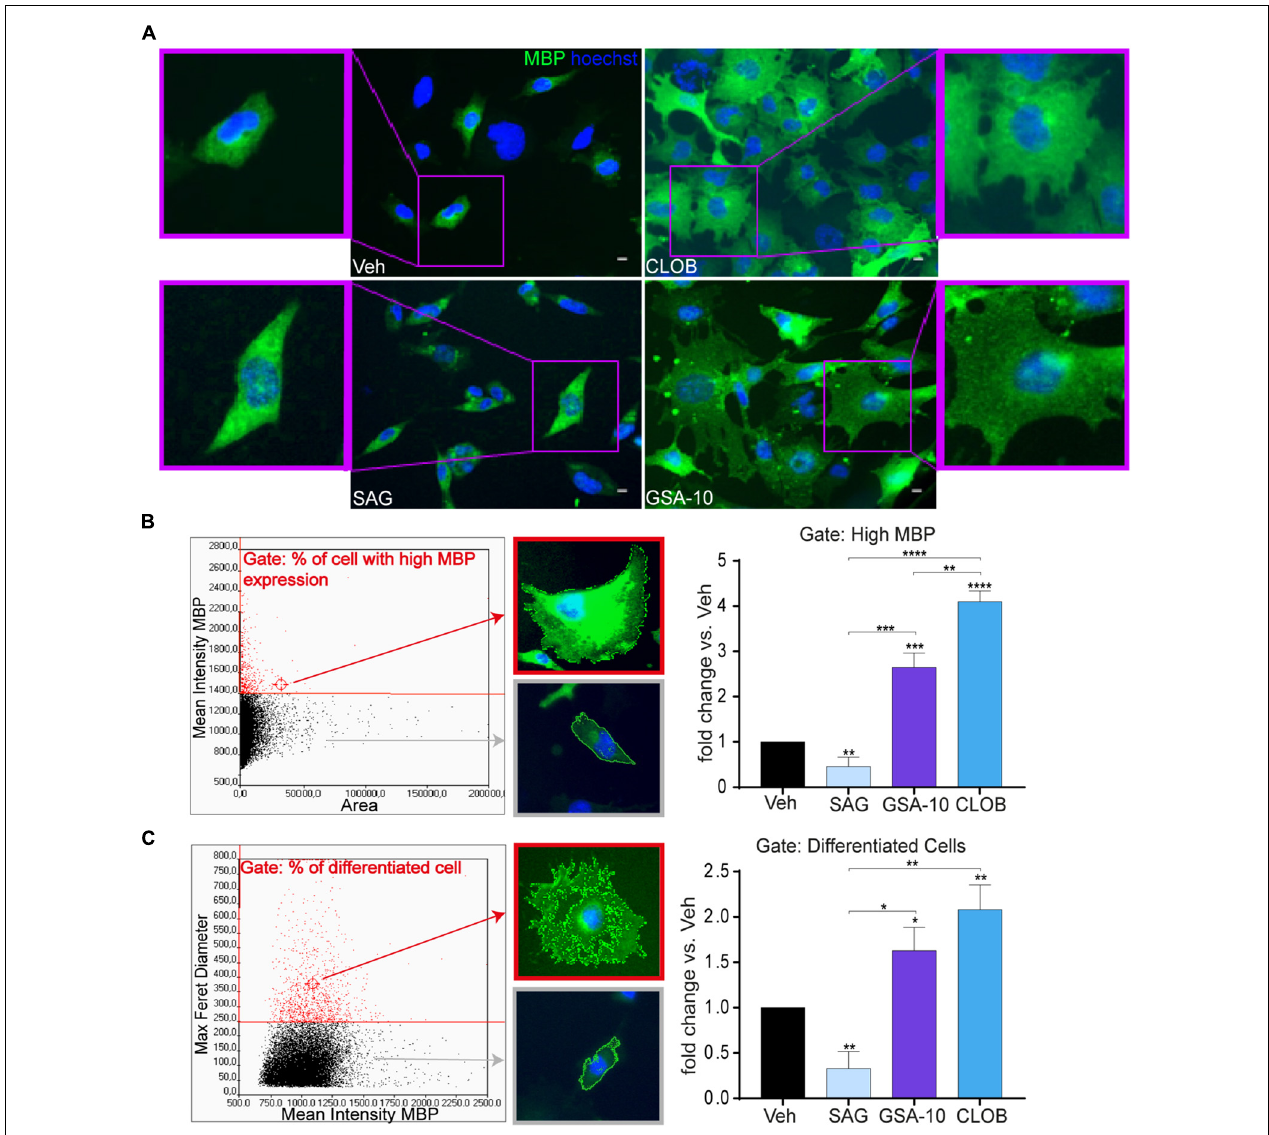
FIGURE 2 | GSA-10 promotes MBP expression and Oli-neuM maturation into myelinating cells, while SAG blocks Oli-neuM differentiation. Oli-neuM was treated for 48 h with 5 µ M SAG, 10 µ M GSA-10, or 10 µ M Clobetasol before IF analysis. (A) Representative images of cell morphology showing enlargement of the cell body (boxed areas). Cells were stained with anti-MBP primary and Alexa 488 secondary antibodies (FITC); Hoechst (blue) = nuclei. Scale bar = 10 µ m. (B,C) Quantification of IF images using ScanR. (B) Left panel: ScanR screen detail of the gate considered: % of cells with high MBP expression [mean MBP > 1400,00 (y)/area (x)]. Cell morphology in the gate and out of the gate was highlighted by a red box and a gray box, respectively. Right panel: % of the cell population within the gate compared to the vehicle condition. Values are mean ± SEM ( n ≥ 3). (C) Left panel: ScanR screen detail of the gate considered: % of cells with differentiated morphology [max Feret diameter (D) > 250 (y)/mean FITC (MBP) (x)]. Fluorescent images show the cell morphology in the gate and out of the gate highlighted by a red box and gray box, respectively. Graph: % of cell population within the gate compared to the vehicle condition. Values are mean ± SEM ( n ≥ 3). Two-tailed paired Student’s t -test was performed for statistical significance versus vehicle, one-way ANOVA with Tukey’s correction multiple comparison test was performed to analyze statistical significance among different treatments. * p < 0.05, ** p < 0.01, *** p < 0.001, and **** p <